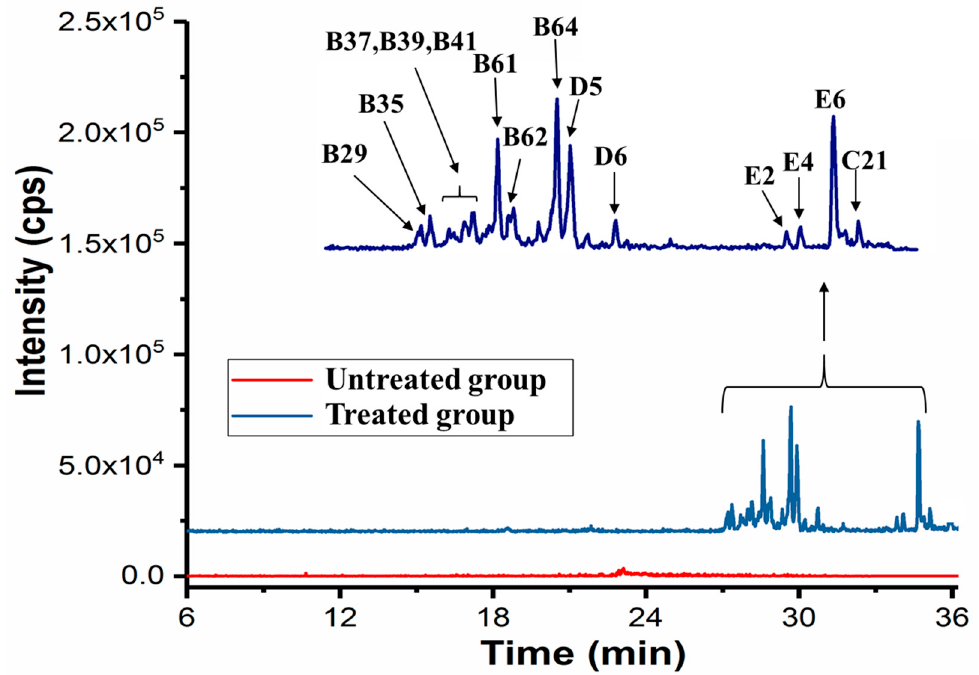
Figure 6. TIC of the extract of L02 cells treated and untreated with fruit extract. All the compound numbers were same with those shown in Table 1 and Table S4.